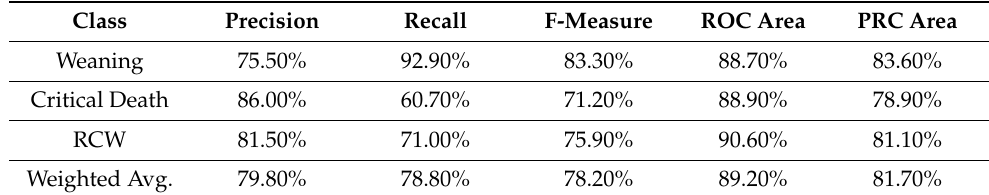
Table 5. C4.5 algorithm performance for Model II with 5 basic and 12 disease attributes.